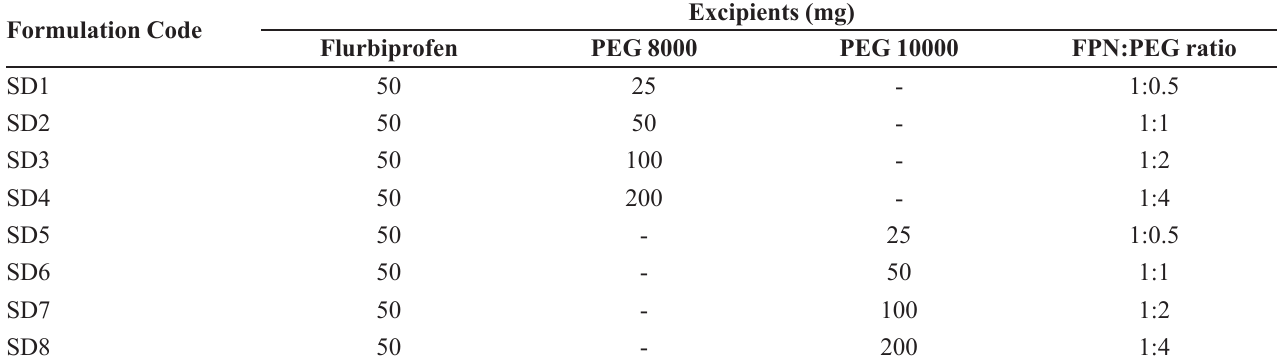
TABLE I - Formulation of FPN solid dispersions using PEGs Formulation